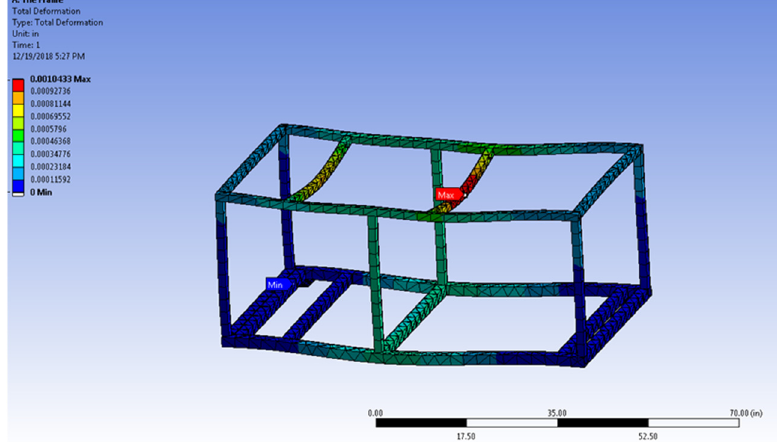
Figure 3. The deformed shape of the supporting frame due to the dead loads indicate maximum deflection of about 0.001 inch occurs on the cross beam that supports the observation chamber. The 3D static analysis in ANSYS is performed by members of capstone senior design team.